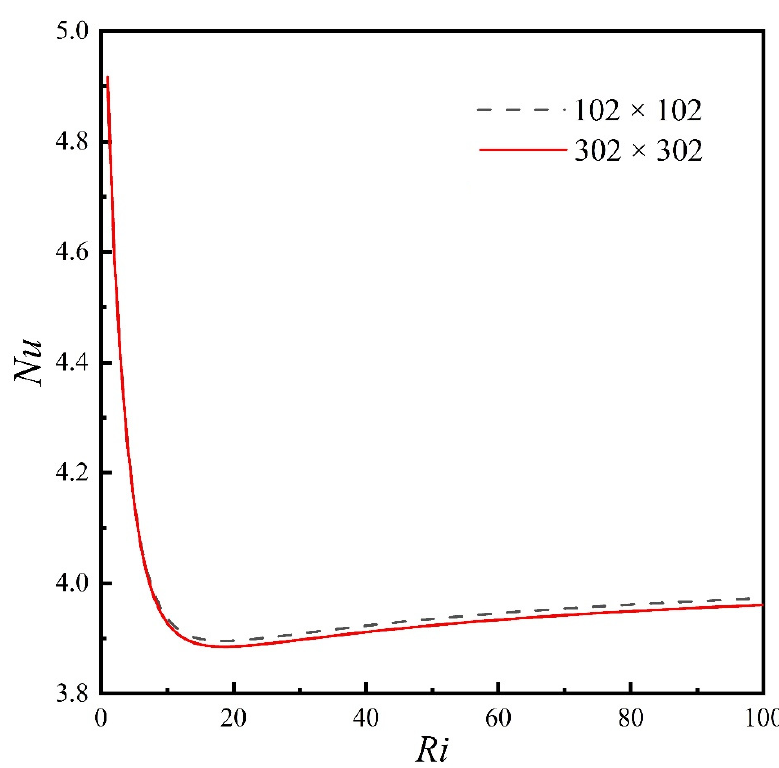
Figure 4. Code validation with Biswas [69] for different porosities at Re = 200, Da = 10 − 4 , and Ri = 10.